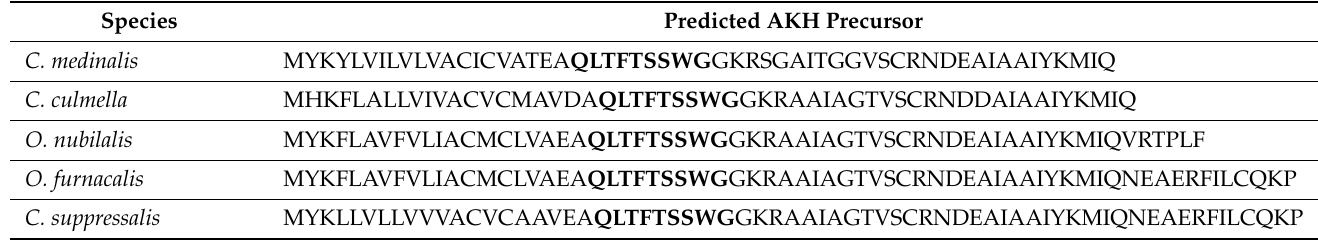
Table 2. Comparison of Manse-AKH precursors in Crambidae moths.